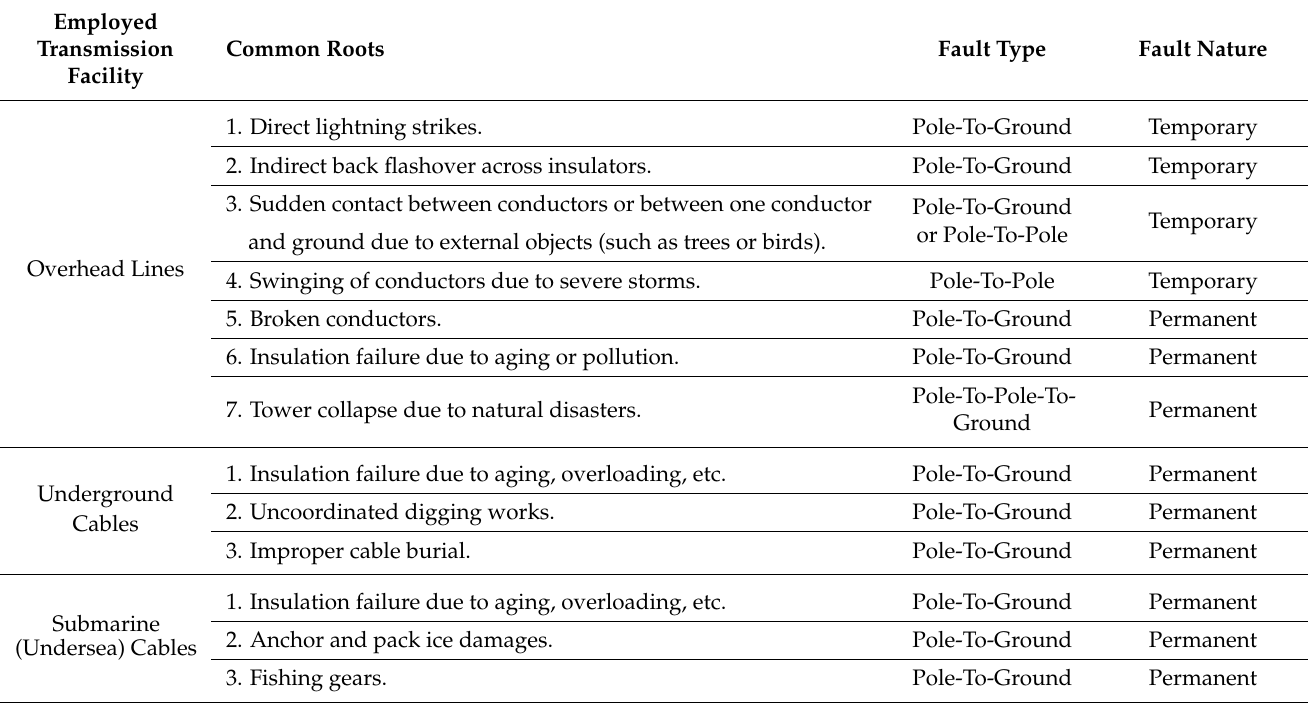
Table 3. Common roots of DC